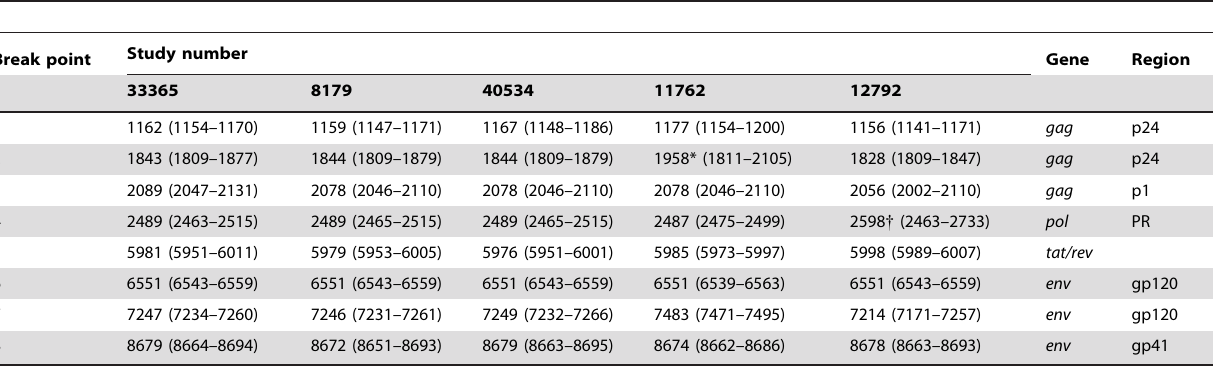
Table 1. jpHMM-assigned breakpoint locations (with 95% confidence intervals) for five HIV-1 A1/D recombinant sequences a .